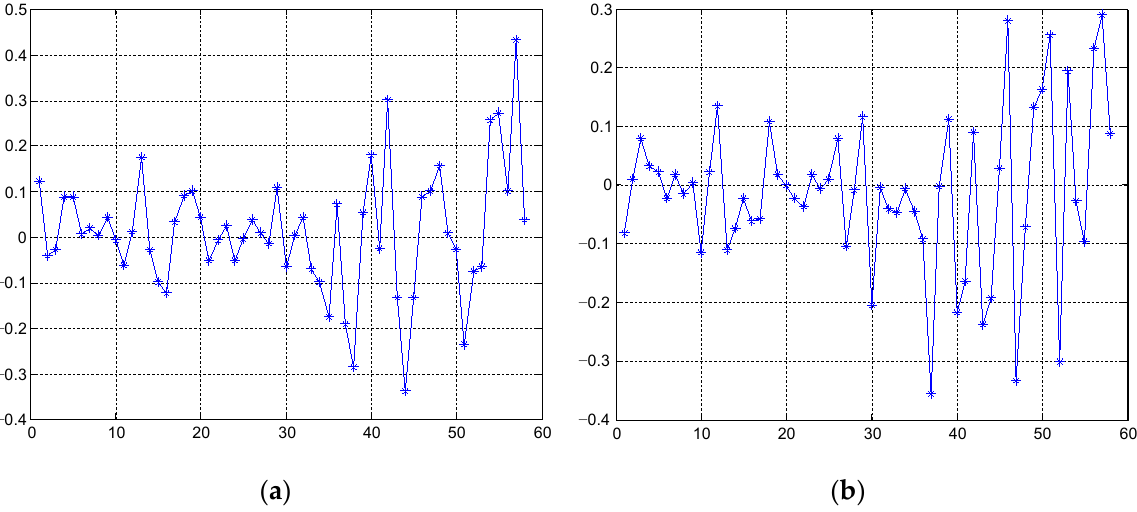
calibration and elevation inversion method based on the elevation transfer of tie-points can between tie-points, and the ordinate is the number of tie-points corresponding to relative elevation effectively realize the high-precision elevation inversion of different data blocks in the same difference. Figure 17. The distribution of average elevation difference for tie-points between adjacent data flight sortie. blocks in each strip, where ( a ) is N510 and ( b ) is N511. The abscissa in the figure is the number of